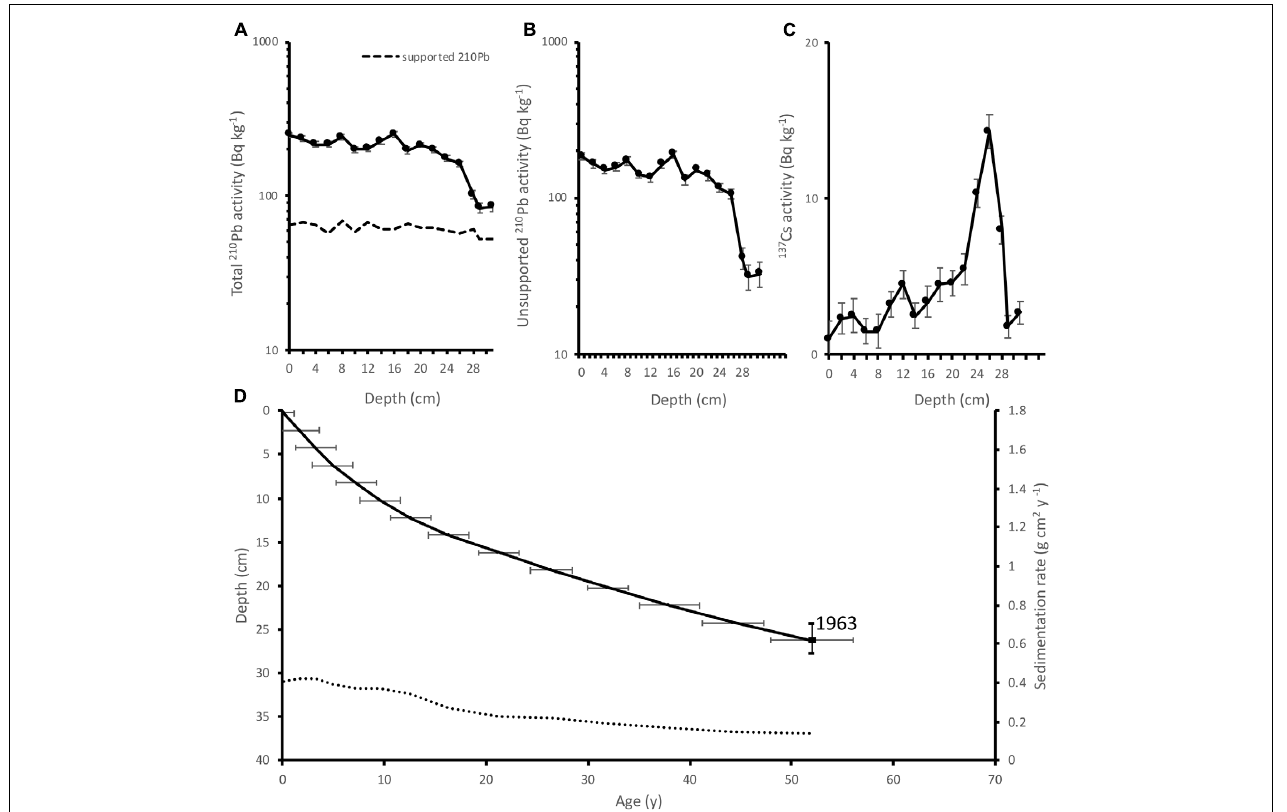
FIGURE 2 | Sediment chronology for Sky Pond (SKP 1) determined by radiometric dating ( Table 1 ), showing down-core activities for (A) : total and supported 210 Pb, (B) unsupported 210 Pb as calculated by subtracting 226 Ra activity from total 210 Pb activity, and (C) 137 Cs activity. (D) Sedimentation rates (dotted line) and 210 Pb dates ( Table 2 ) were derived from the constant rate of supply (CRS) model and corrected using the 137 Cs peak resulting from nuclear weapons testing in 1963. Since total 210 Pb activity (A) is still significantly above that of the supporting 226 Ra in the deepest sample analysed, at 31–31.5 cm, it appears that the core spans a period of no more than a few decades. 137 Cs activity in the core has a well resolved peak at 26.25 ± 1.75 cm that records the 1963 fallout maximum from the atmospheric testing of nuclear weapons (C) . Corrected 210 Pb dates have been calculated using the 1963 137 Cs date as a reference point. The results are unequivocal for the post-1963 period. During that time sedimentation rates increased from a mean value of 0.16 g cm − 2 y − 1 (0.30 cm y − 1 ) during the 1960s and 1970s to 0.42 g cm − 2 y − 1 (1.3 cm y − 1 ) during the early 21st